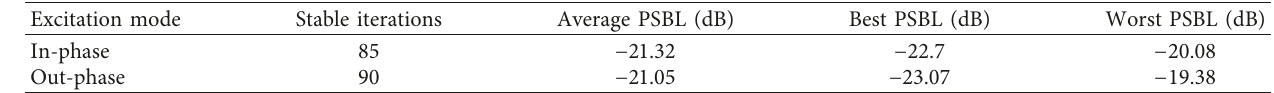
Figure 12: Pattern with equal amplitude and out-phase excitation in the PS mode. Table 4: Comparison of robustness between in-phase and out-phase TMSLA.